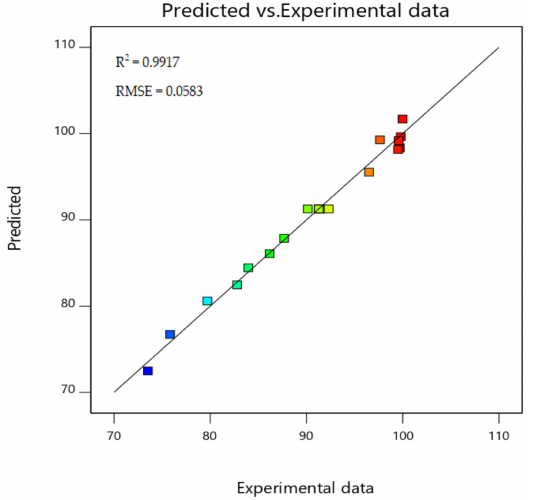
Figure 9. Predicted values vs. experimental results plot for the turbidity removal